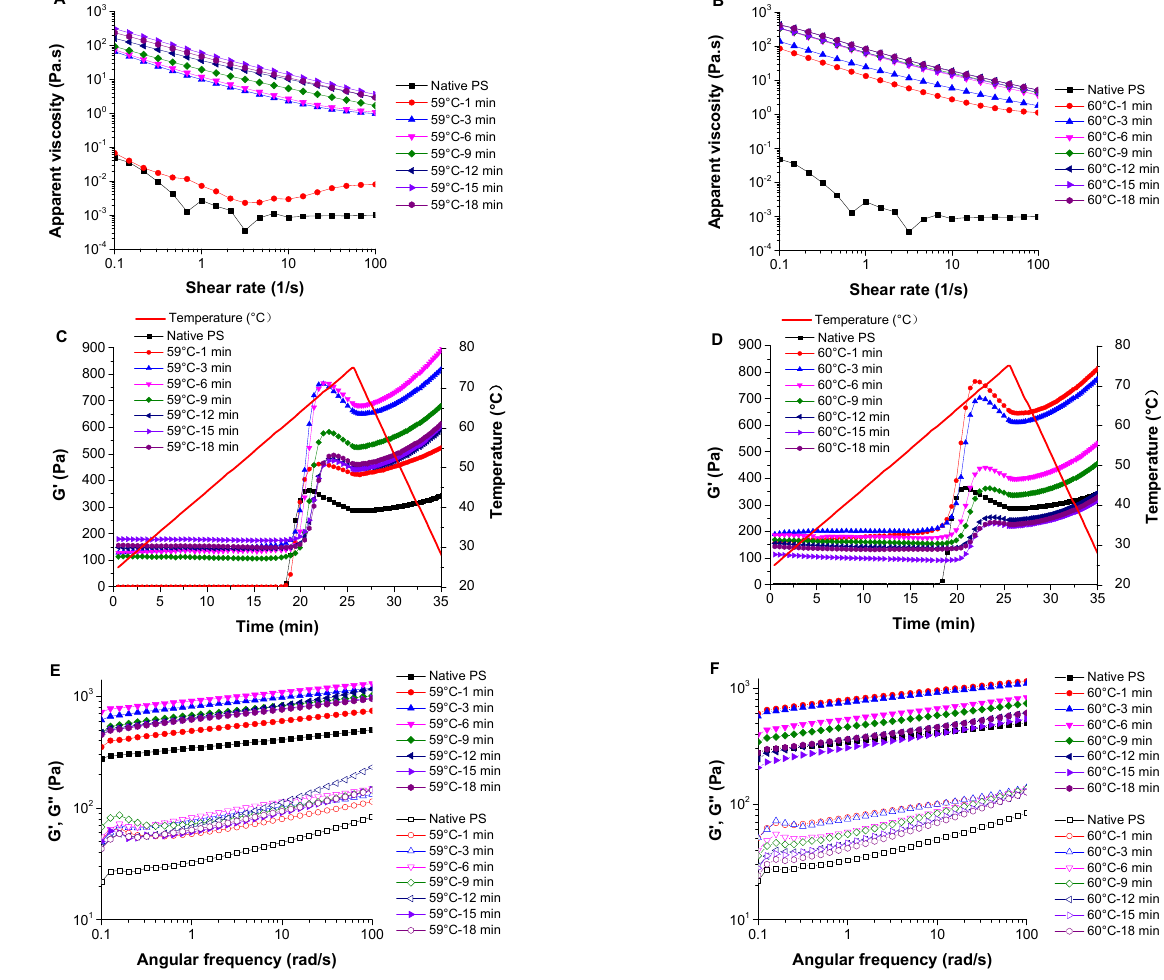
Figure 3. The apparent viscosity flow ( A , B ), temperature dependence of G’ ( C , D ), and frequency dependence of G’ (solid symbols) and G” (open symbols) ( E , F ) of native and partially gelatinized potato starch samples ( A , C , E : pre-heated at 59 °C; B , D , F : pre-heated at 60 °C). Table 3. Effect of shear rate and frequency on the consistency index (K, K (cid:48) , and K (cid:48)(cid:48) ), flow behavior index (n, n (cid:48) , and n (cid:48)(cid:48) ), and determination coefficient (R 2 , R (cid:48) 2 , and R (cid:48)(cid:48) 2 ) of starch pastes and gels pre-heated at 59 ◦ C and 60 ◦